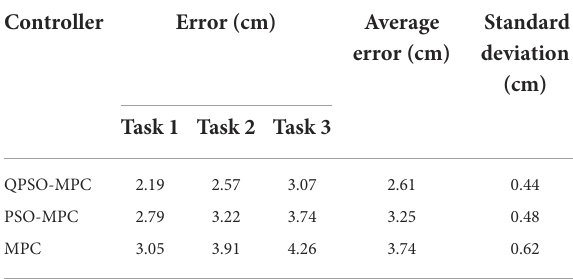
TABLE 2 The tracking errors of the